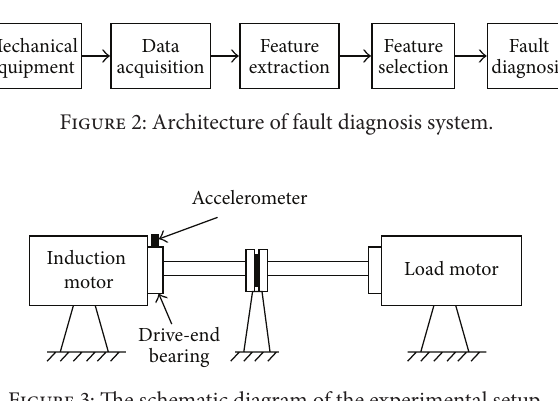
Figure 3: The schematic diagram of the experimental